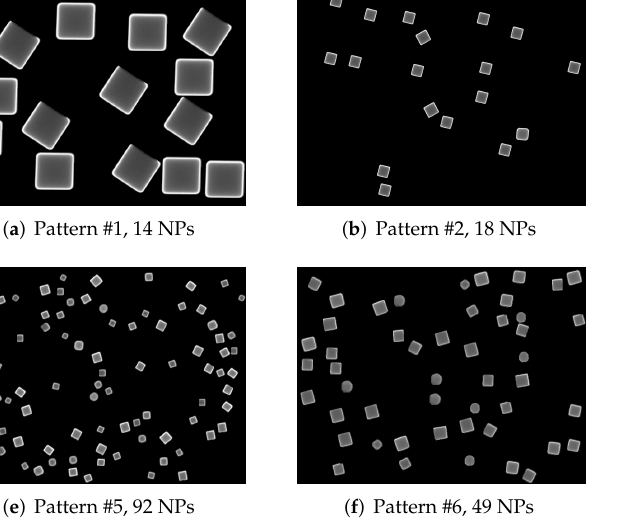
Figure 5. Synthetic images generated using the different patterns with varying numbers of scattered nanoparticles. Unlike the original micrographs, these images do not contain overlapping